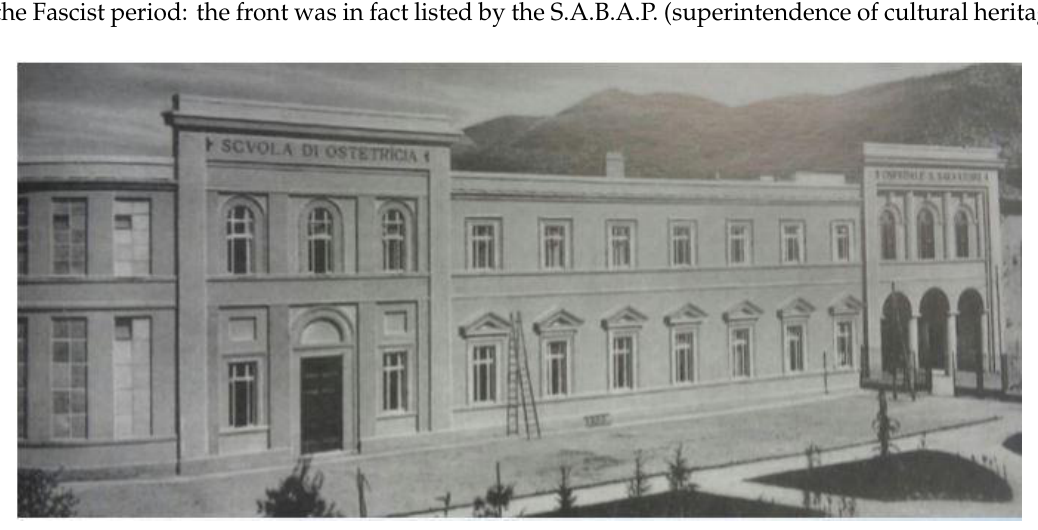
Figure 4. Historical photo of the hospital dating back to the completion of the expansion works in the 1930s.